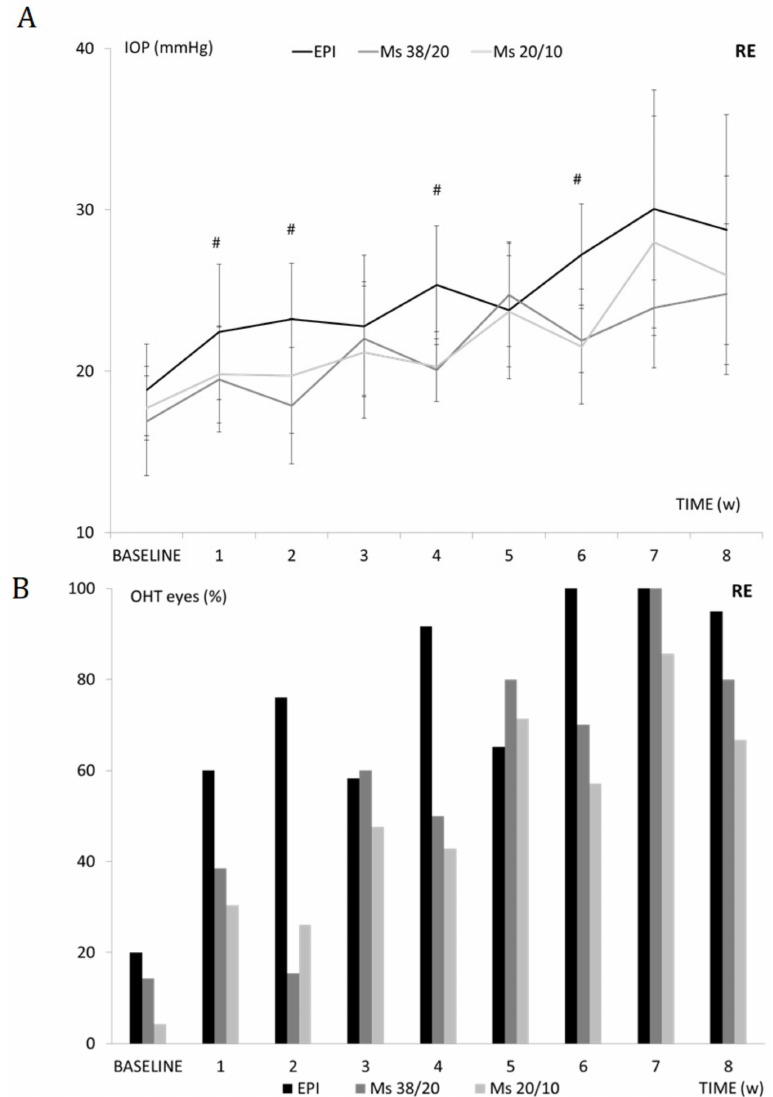
Figure 4. Analysis of intraocular pressure (IOP). ( A ) Right eye IOP curve in ocular hypertensive (OHT) models over follow-up. ( B ) Percentage of OHT right eyes (>20 mmHg) in the three OHT models over follow-up. Abbreviations: EPI: episcleral sclerosis model; Ms38/20: 38/20 microsphere model; Ms20/10: 20/10 microsphere model; RE: right eye; IOP: intraocular pressure; w: weeks, OHT: ocular hypertension; (%): percentage; #: statistical significance p < 0.020, for Bonferroni correction for multiple